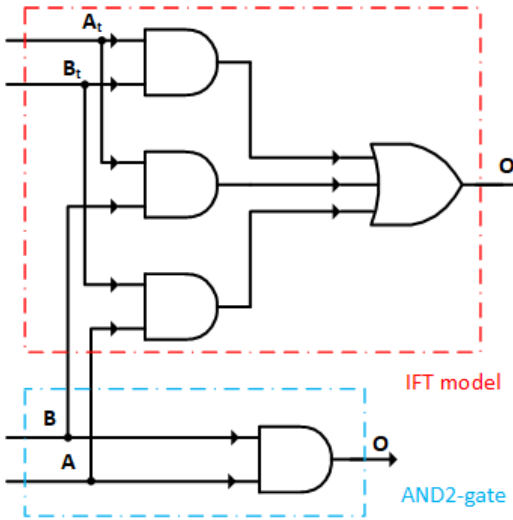
Figure 1. The AND-2 gate-level IFT model [20].